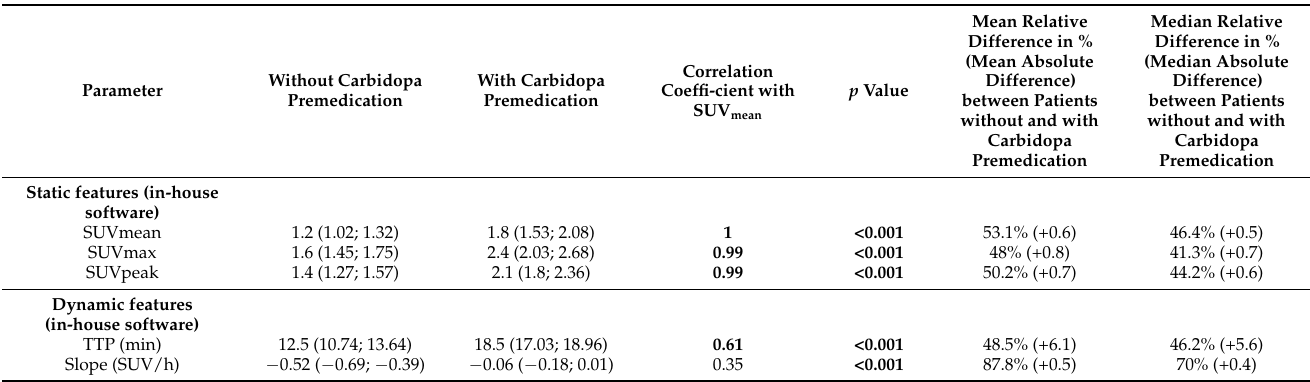
Table 2. Healthy brain extracted parameters in patients without and with carbidopa